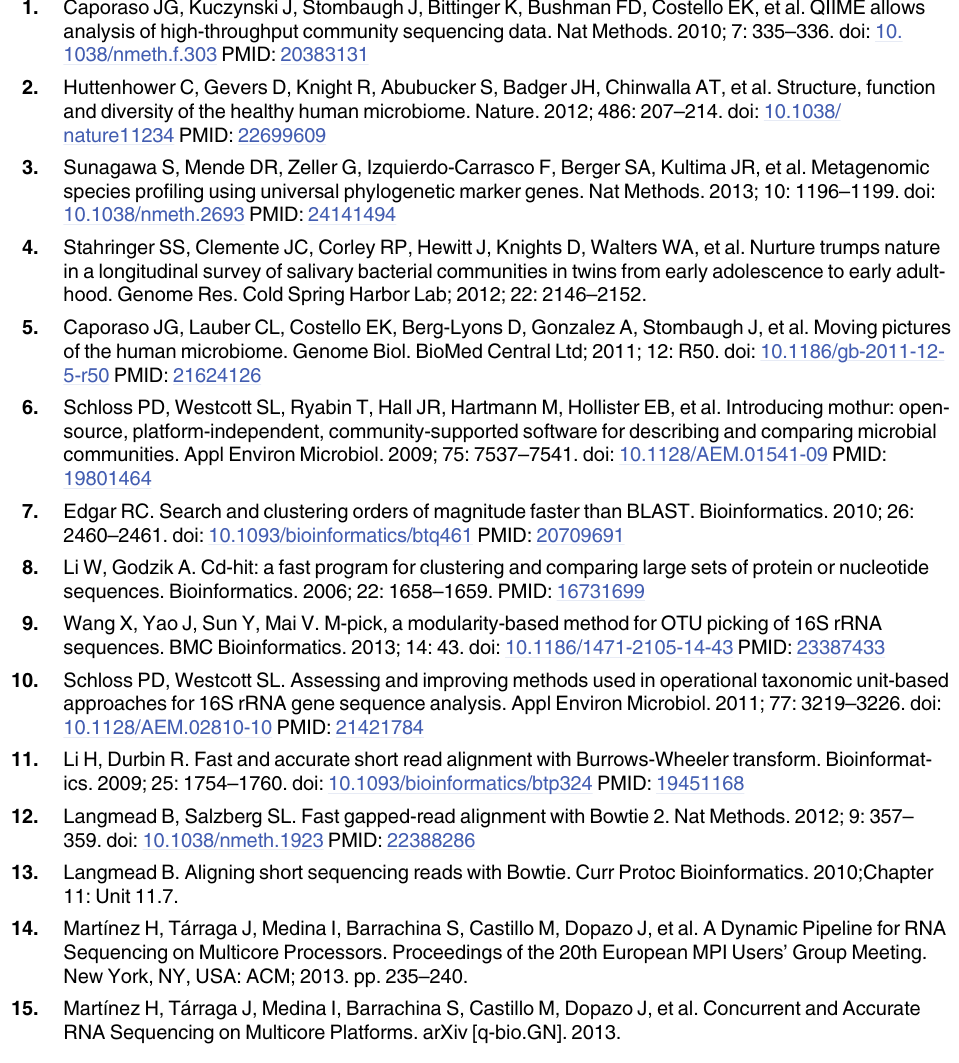
S7 Fig. QR code for the NINJA-OPS download website. This Quick Response (QR) code, stylized to resemble a gapped multiple alignment of DNA sequences (including clip art from public domain at http://www.wpclipart.com), is a functional QR code provided for convenient linking to the NINJA-OPS source code and pre-built binaries hosted at http://ninja-ops.ninja, and for convenient sharing and distribution of the tool in poster presentations, slide shows, and other visual